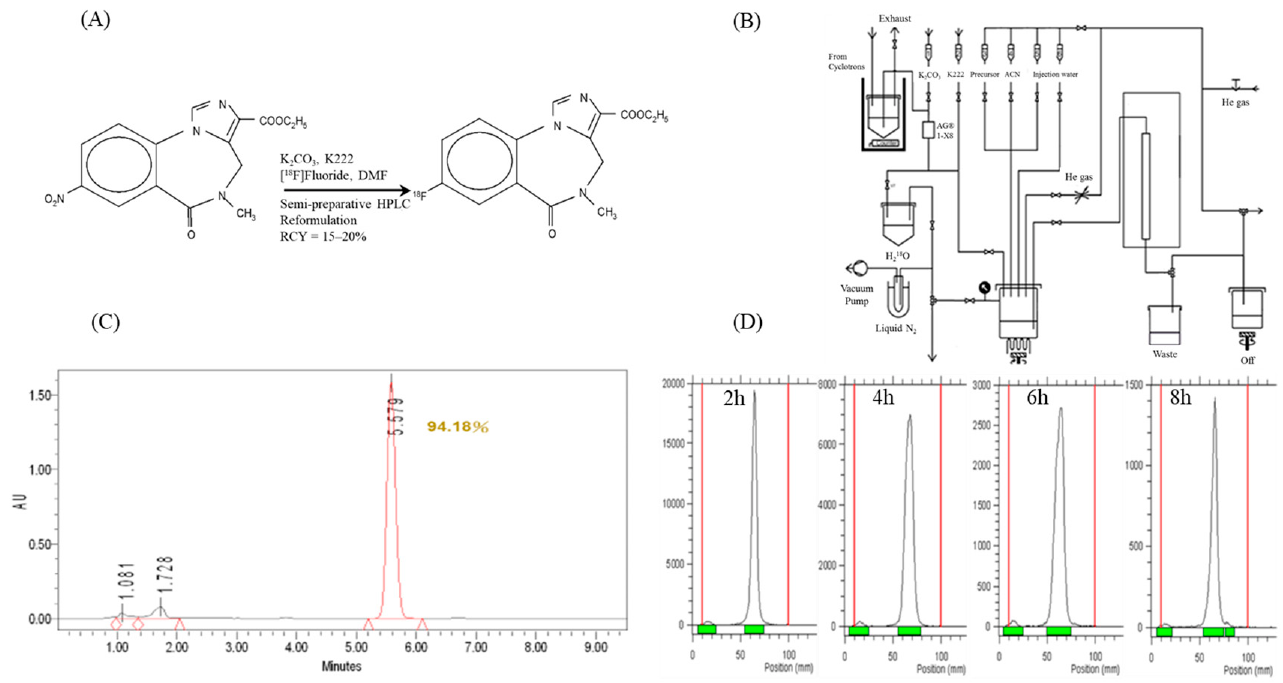
Figure 1. ( A ) Scheme of synthesis of [ 18 F]flumazenil. The non-carrier added [ 18 F]flumazenil radio- fluorination reaction with tetra-butyl ammonia hydrogen carbonate phase catalyzed in DMSO nitro- flumazenil solution. ( B ) Flowchart (LabView Operational Window) for the synthesis of [ 18 F]fluma- zenil. ( C ) The diagram of radiochemical purity of [ 18 F]flumazenil. Radio-HPLC analysis of [ 18 F]flumazenil using a COSMOSIL 5C18 MS-II column (4.6 × 150 mm), a flow rate of 1 mL/min, and mobile phase of H 3 PO 4 /acetonitrile 70:30. ( D ) The stability study of [ 18 F]flumazenil was performed on radio-TLC, and the analysis used a Merck Si-60 plate with an ethyl acetate:ethanol (80/20) solu- tion. Separate display at 2, 4, 6, and 8 h later. Radio-TLC was performed on a Merck Si-60 plate with an ethyl acetate:ethanol (80/20) solution.